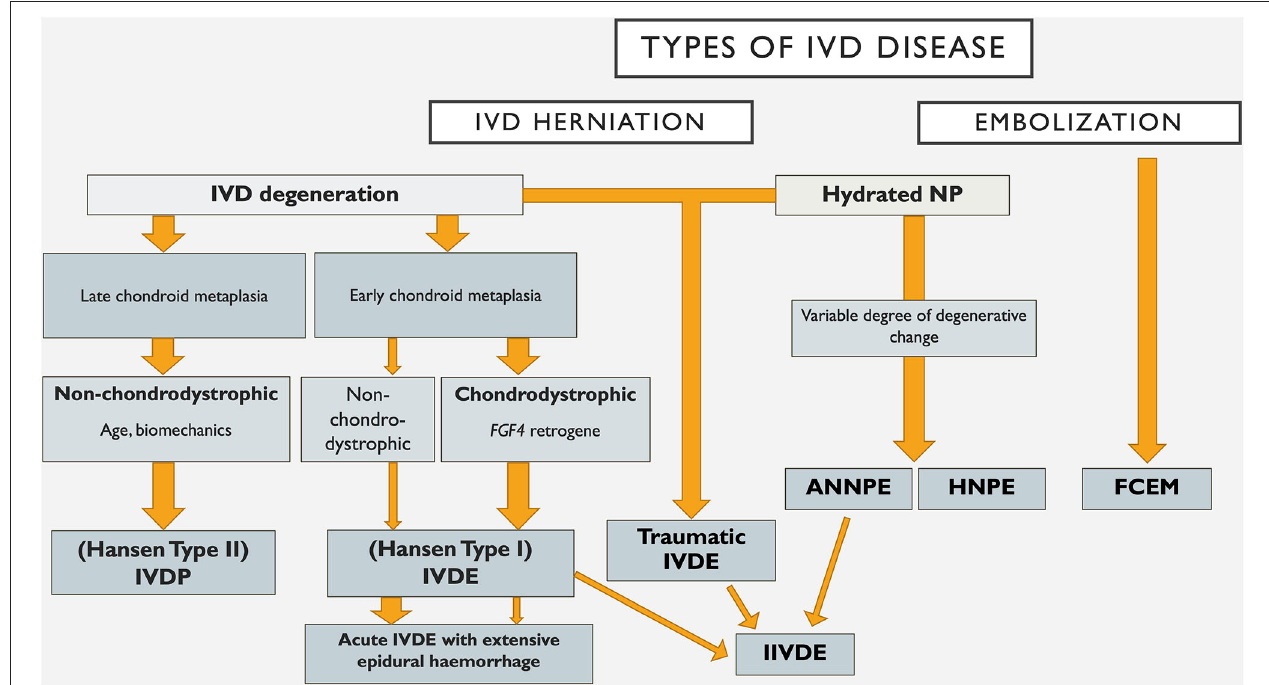
FIGURE 1 | An example of how a classification system for intervertebral disc disease in dogs might evolve. IVD, intervertebral disc; NP, nucleus pulposus; IVDP, intervertebral disc protrusion; IVDE, intervertebral disc extrusion; HNPE, hydrated nucleus pulposus extrusion; ANNPE, acute non-compressive nucleus pulposus extrusion; IIVDE, intradural/intramedullary intervertebral disc extrusion; FCEM, fibrocartilaginous embolic myelopathy.